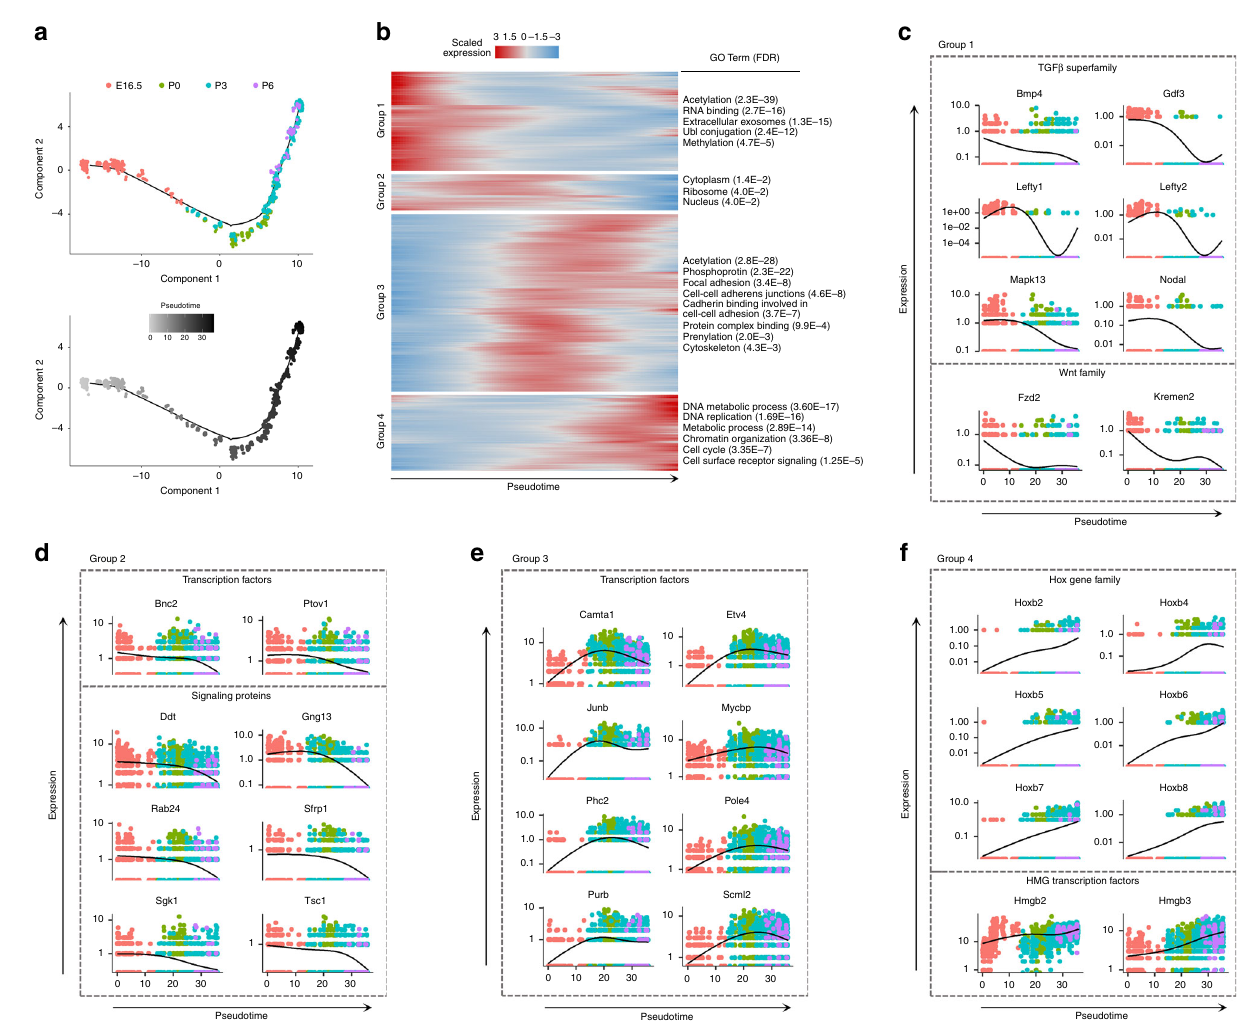
Fig. 6 Transcriptional dynamics and regulatory networks within the SSC trajectory. a Trajectory analysis of SSC-enriched clusters from each developmental age ordered through pseudotime. b Heatmap representation of four broad gene expression patterns that vary as a function of pseudotime. Associated gene ontology (GO) terms and false discovery rates (FDR) are reported for each group. c – f Select protein families and pathways that are differentially expressed across pseudotime corresponding to gene groups in b . Dot coloring in c – f corresponds to developmental ages illustrated in being ID4-eGFP + or ID4-eGFP − and transplanted into testes of adult germ cell-depleted recipient males. Two months later, colonies of donor-derived spermatogenesis were assessed via X- gal staining.